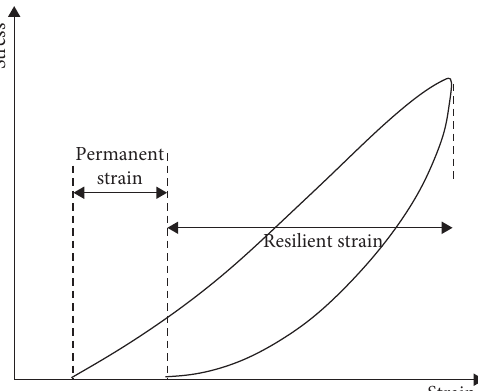
Figure 1: Simplified stress-strain behaviour in granular materials during one loading cycle